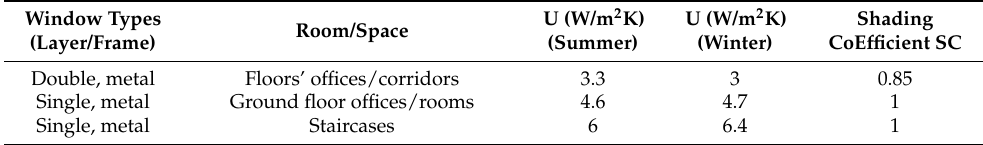
Table 6. Heat transfer coefficients U (W/m 2 K) and shading coefficients SC of windows. Window Types